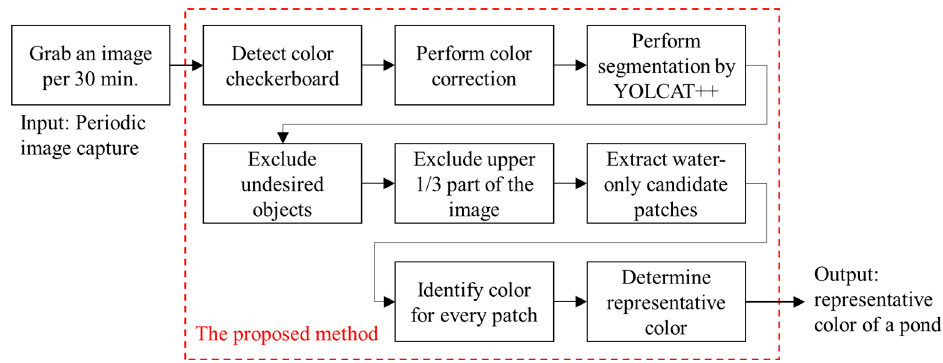
Figure 17. Block diagram of the proposed system implemented at experimental sites.